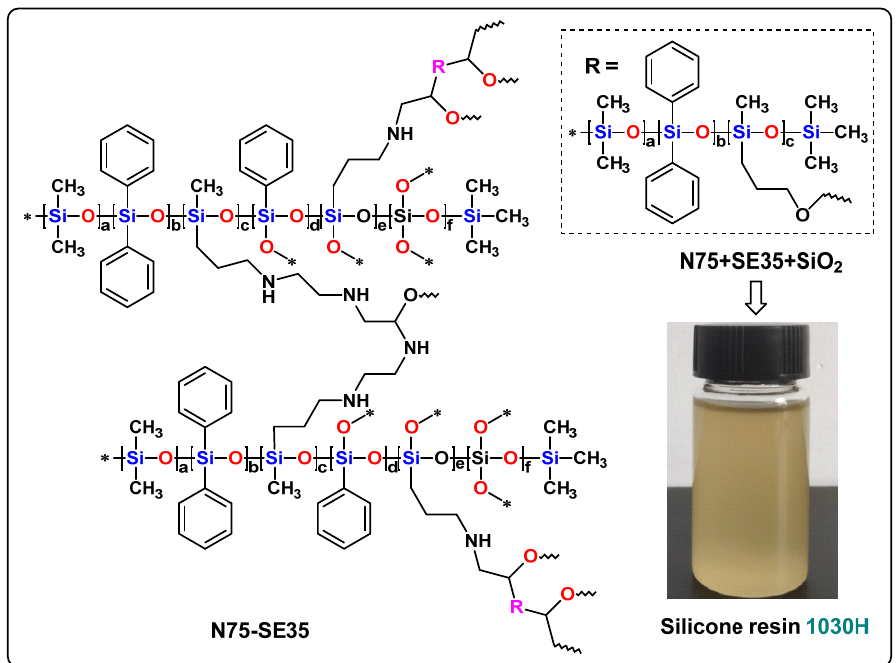
Figure 3. Reaction product of N75 and SE35.